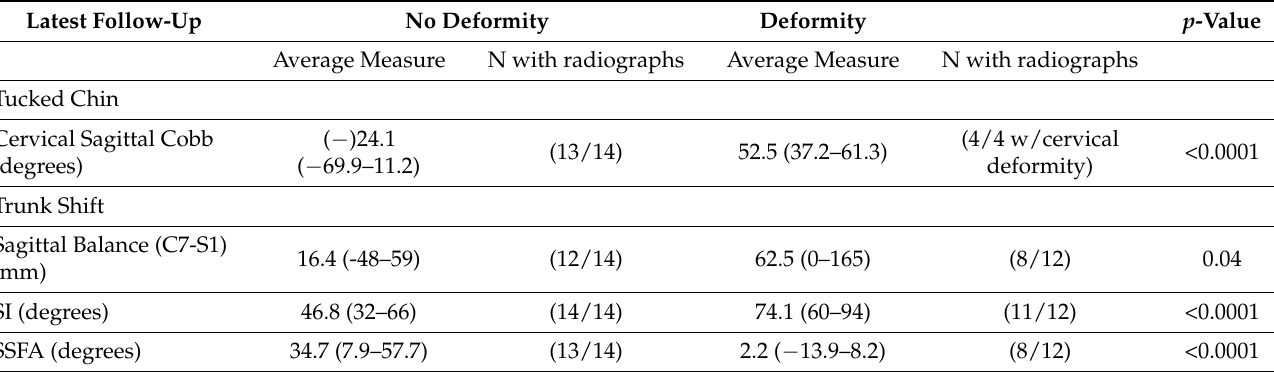
Table 4. Sagittal parameters between those identified with and without obvious deformities on screening. Sagittal measurements were only performed on upright radiographs. These data indicate that subjective screening identified objectively measured differences. N = (number with upright lateral that allowed for each measurement/total number with upright radiographs).